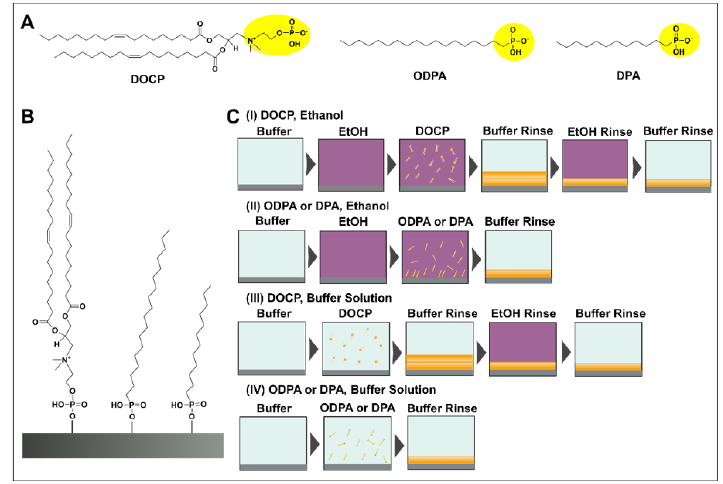
Figure 1. ( A ) Molecular structures of the one- and two-tail amphipathic molecules functionalized with phosphate groups. ( B ) Proposed schematic of DOCP, ODPA, and DPA (from the left) molecules bonding to a TiO 2 surface based on coordination chemistry. ( C ) Overview of experimental strategy for coating phosphate-functionalized molecules onto a TiO 2 surface based on deposition in ( I , II ) ethanol or ( III , IV ) buffer solution.